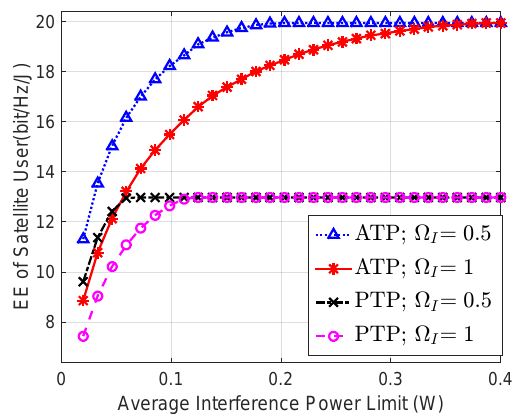
Figure 6. The EEs of the satellite user versus I th for different interference link conditions with P av = P m = 0.12 W and m I =